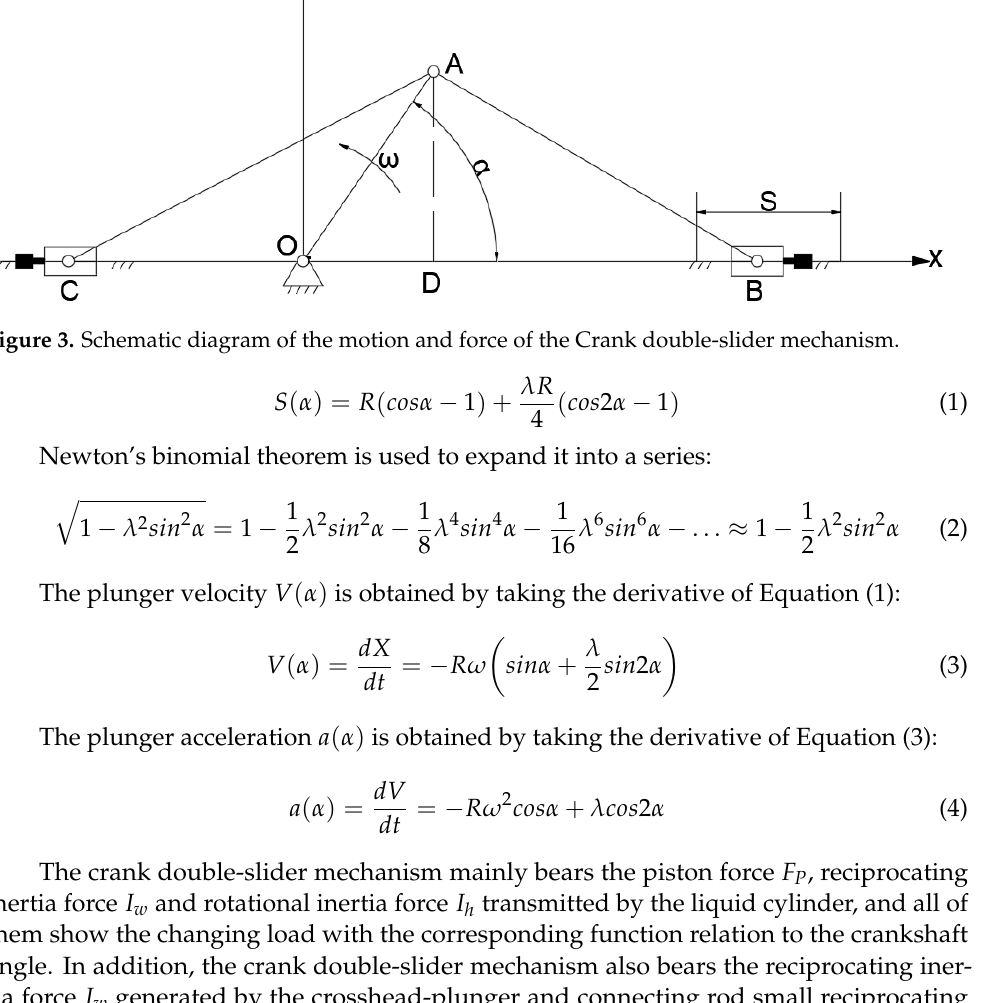
horizontally opposed to it is called plunger 1 ′ , and so on. The crankshaft rotation angle